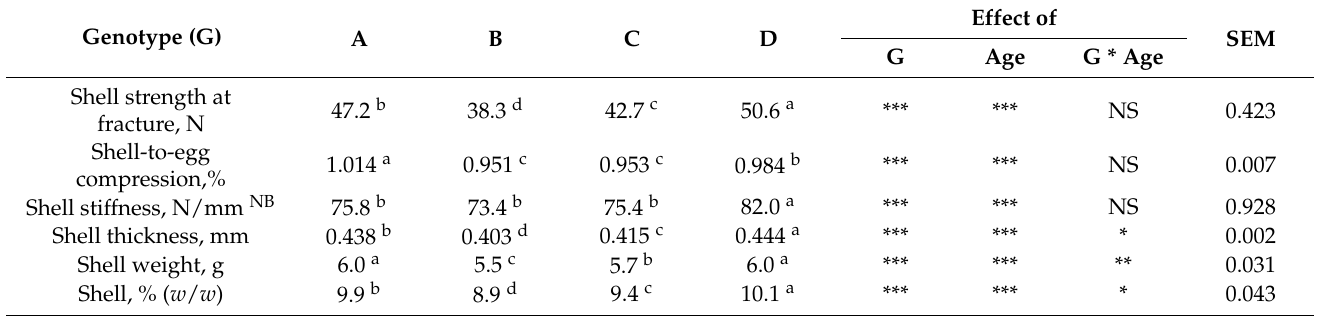
Table 2. Effect of hen genotype, A, B, C, and D, age, and their interaction on LS-means of egg shell parameters between the 21st and 54th week of age, n = 180 for genotype A and 270 for genotypes B, C and D.